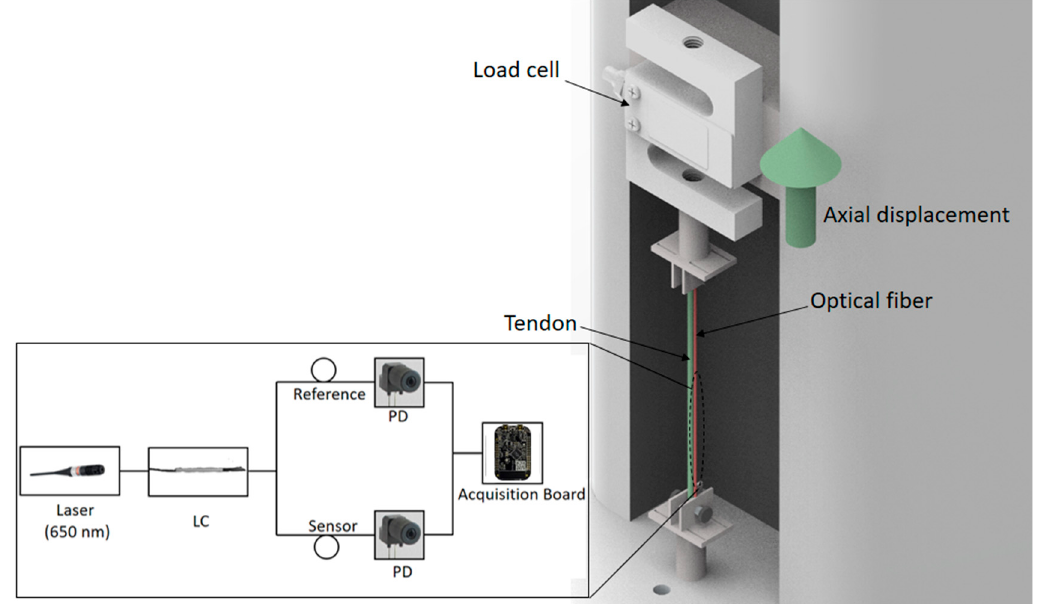
Figure 1. Experimental setup for the mechanical characterizations and sensor analysis.